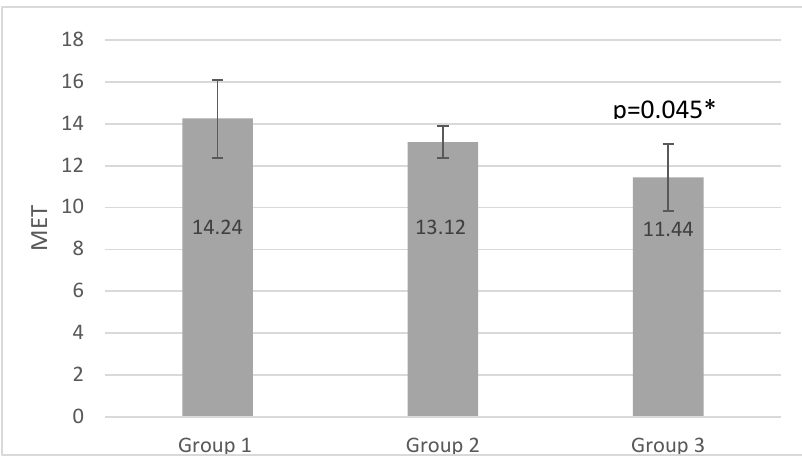
Figure 1. MET results of the groups (* p <0.05).